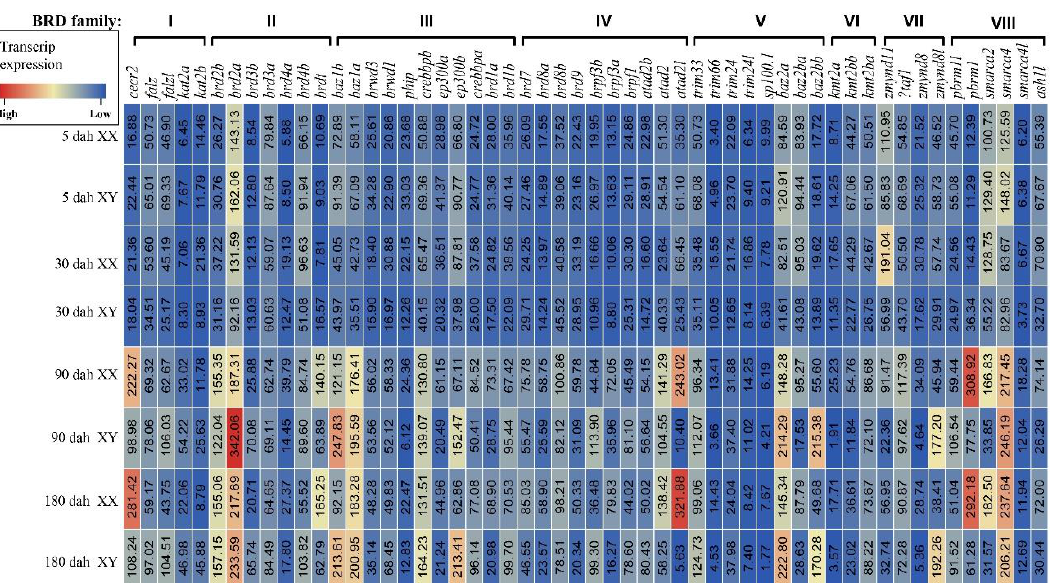
Figure 3. Transcriptome data of BRDs in eight tilapia tissues. Red shows high expression level and blue shows low expression level. Each column represents a different gene, and each row represents a different tissue.